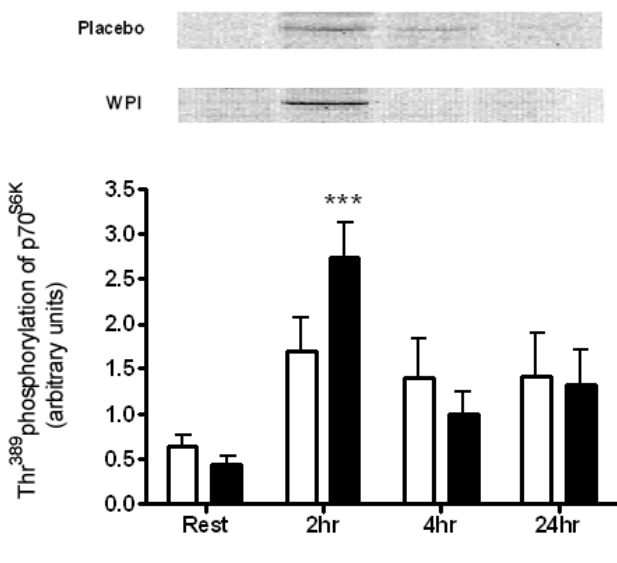
Figure 4 Phosphorylation of p70 S6K at Thr 389 in human skeletal muscle at rest and 2, 4 and 24 h post-exercise during placebo and WPI trials. Values are arbitrary units (mean ± SEM; n = 7 per trial). Open bars represent placebo, closed bars represent WPI. *** P < 0.001 vs. resting